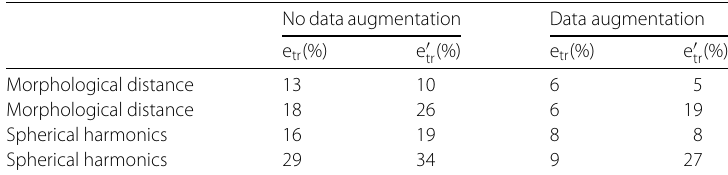
Table 1 Percentage of wrongly-assigned labels, averaged over all shapes, or over mechanical clusters, for the training data, with either the morphological or spherical harmonics distances, using data augmentation Nodataaugmentation Data augmentation e tr (%) e (cid:9) tr (%) e tr (%) e (cid:9) tr (%) Morphological distance